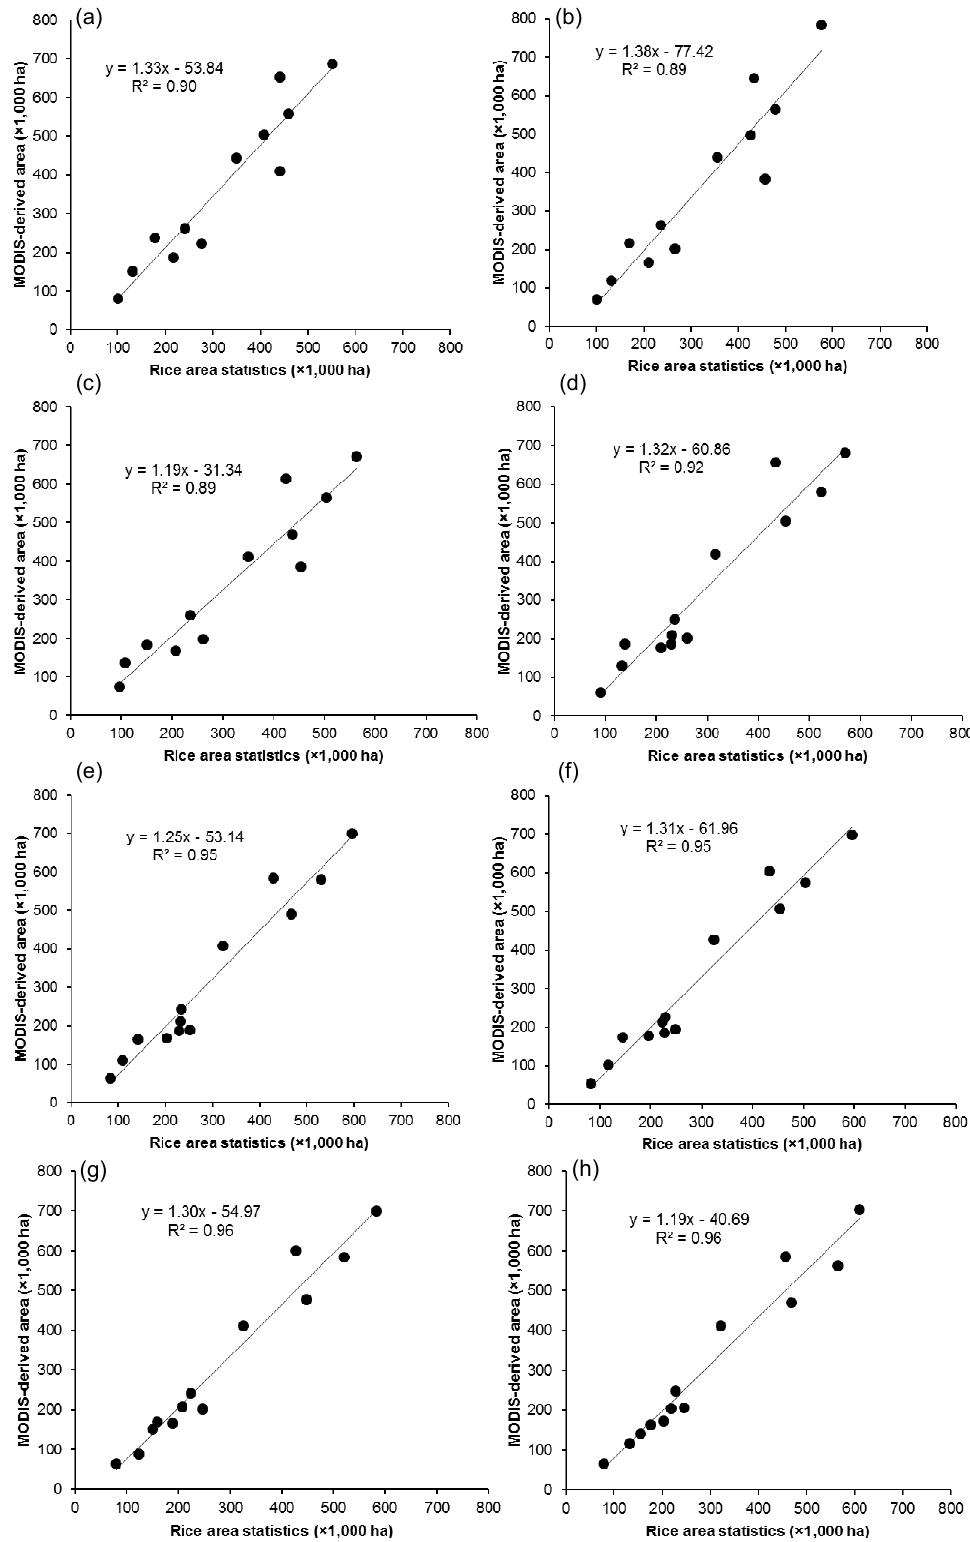
Figure 7. Results of regression analysis between MODIS-derived rice area and rice area statistics at the provincial level for the entire region: ( a ) 2001, ( b ) 2002 ( c )